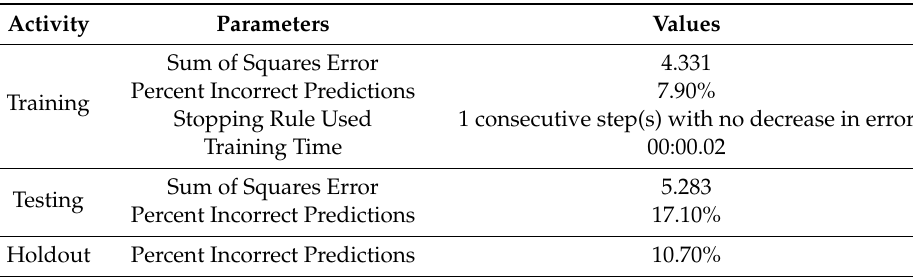
Table 7. Validation model summary.